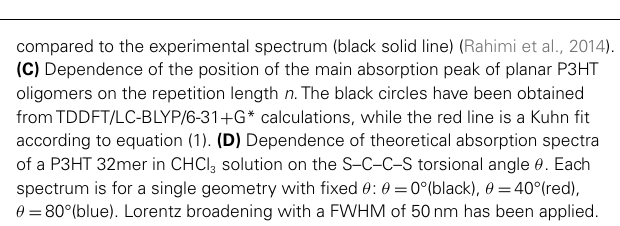
FIGURE 1 | Continued (A) Molecular structure of P3HT in the crystal (left) and a snapshot from the MD simulation in CHCl 3 solution with force field II (right). For clarity, the hexyl groups have been replaced by methyl groups. (B) Top panel: theoretical LC-BLYP (red) and experimental (black) absorption spectra of P3HT in a perfect crystal. Bottom panel: theoretical absorption spectra of P3HT in CHCl 3 solution obtained with force field I and LC-BLYP (green dotted line), force field II and LC-BLYP (blue dashed line), and force field II and PBE0 (black solid line)